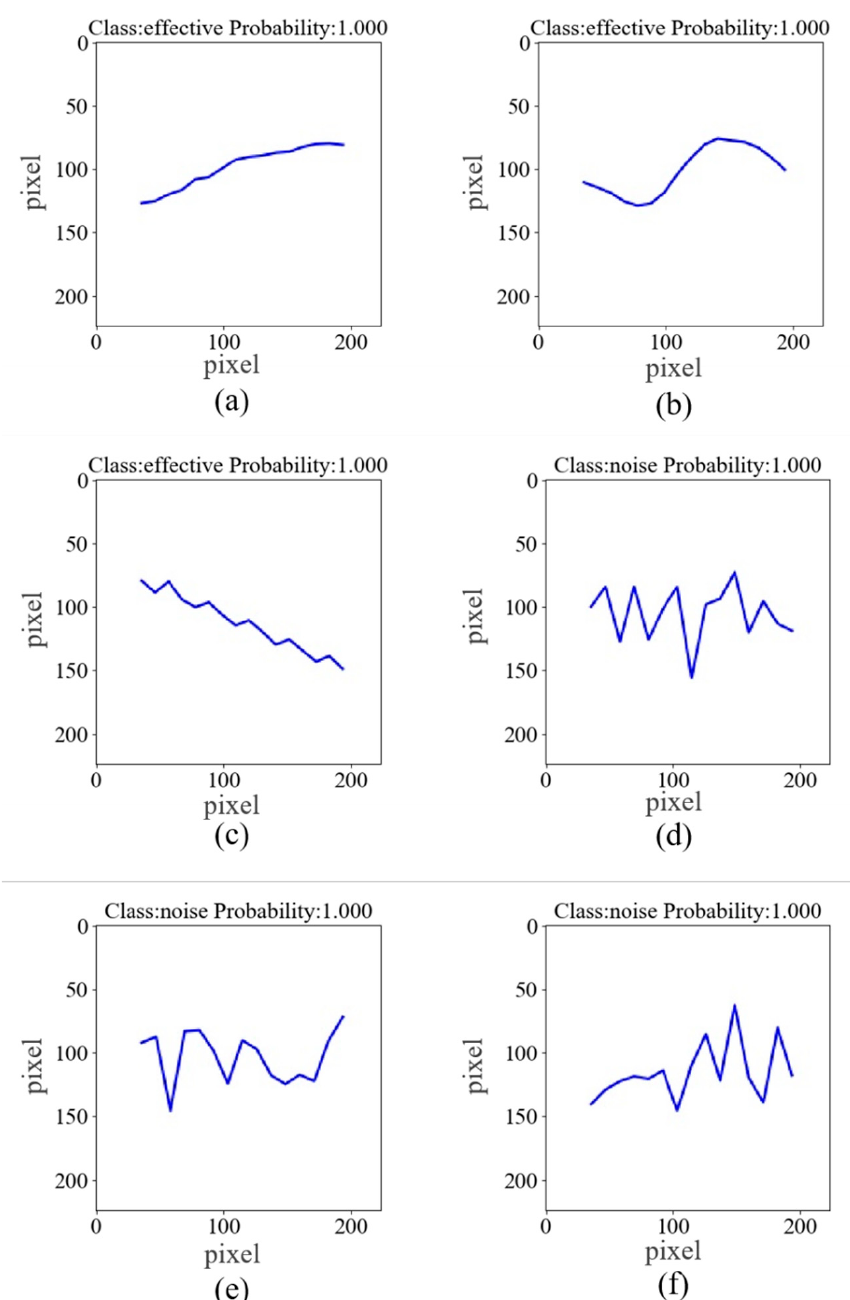
Figure 6. The trained MobilenetV2 network can predict the six right singular vectors as ( a – f ), re- spectively.